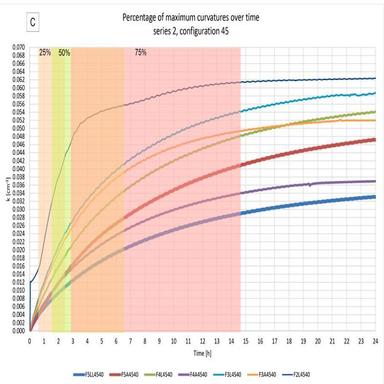
Different percentages of maximum curvature k over time of the second series, "configuration 45".